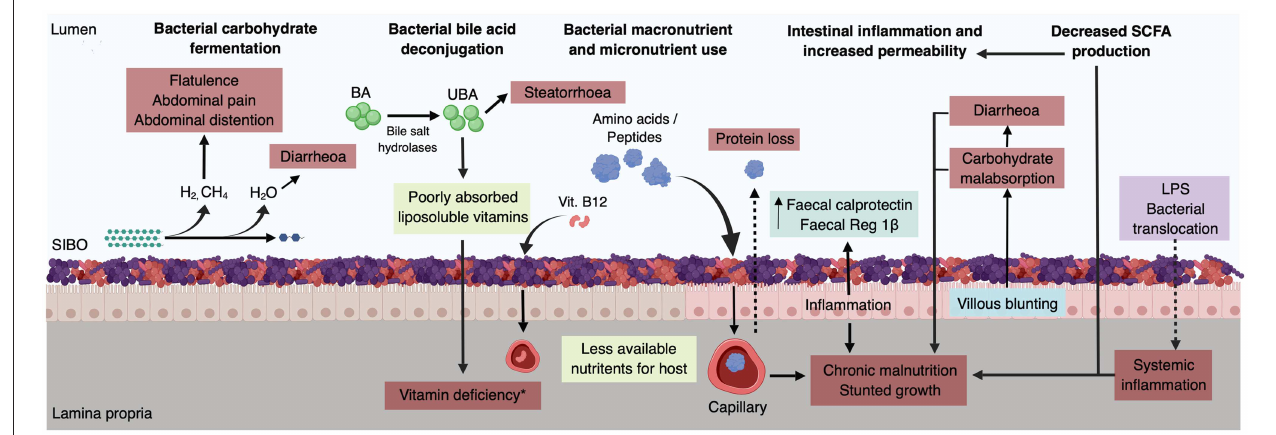
FIGURE 3 | Mechanisms through which SIBO affects the host. The dotted arrows indicate increased intestinal permeability. * Includes vitamin A, D, E, and vitamin B 12. Vitamin K is synthesised by the gut microbiota, and thus its deficiency in this context is very unlikely. BA, bile acids; UBA, unconjugated bile acids; LPS, liposaccharides. Created with